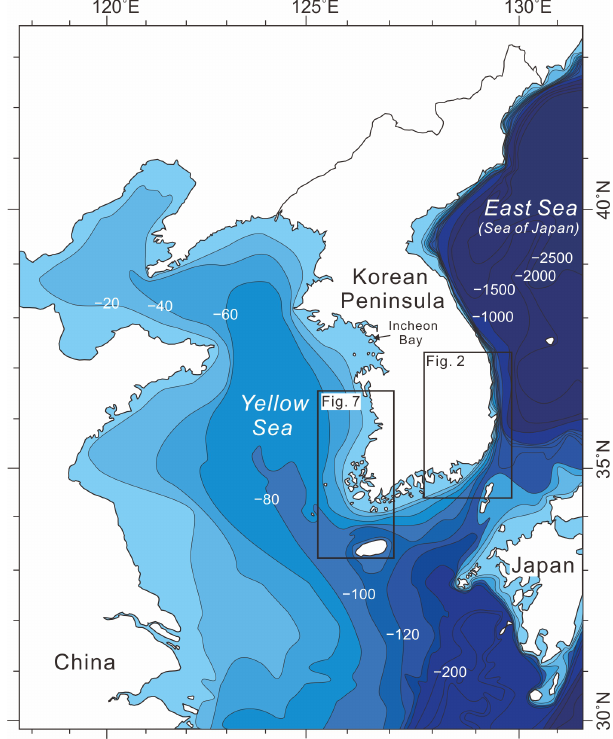
Figure 1. Bathymetry around the Korean Peninsula (modified after Chough et al., 2000, 2004; Cummings et al., 2016). Bathymetric contour interval is in meters. Detailed maps with sampling areas are shown in Figs. 2,